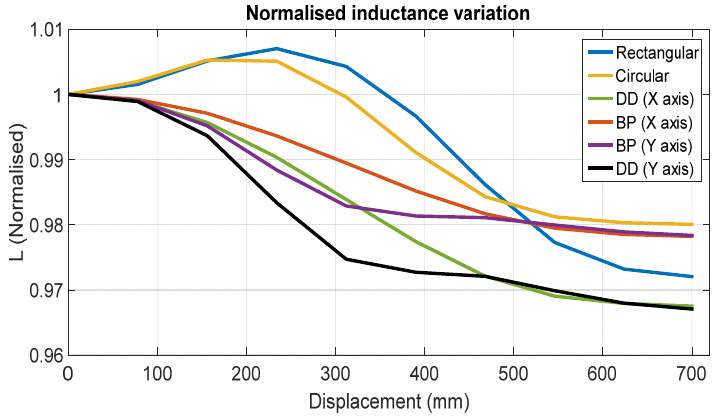
Figure 17. Normalized primary inductances vs. displacement.